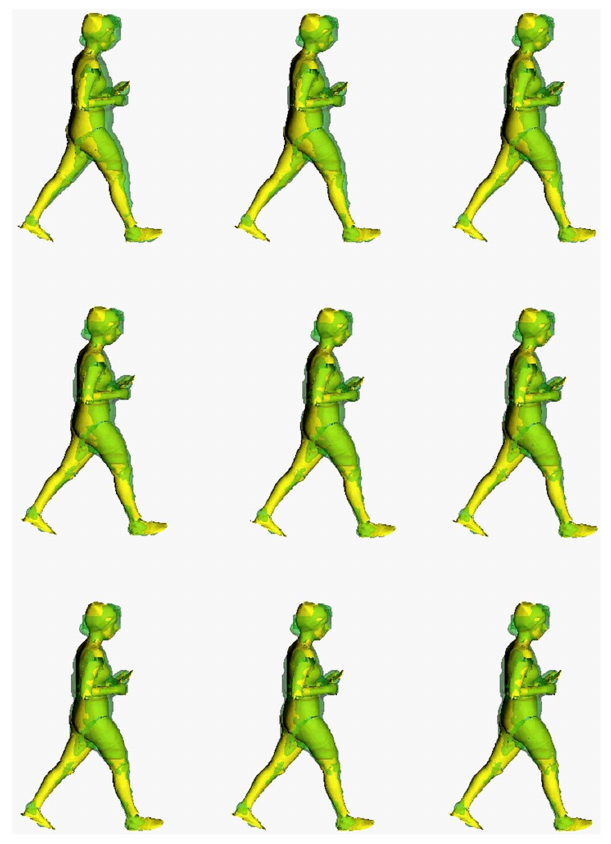
Figure 5. Example of nine iterations of the articulated-ICP algorithm for matching of the model (yellow) to visual hull data (green).